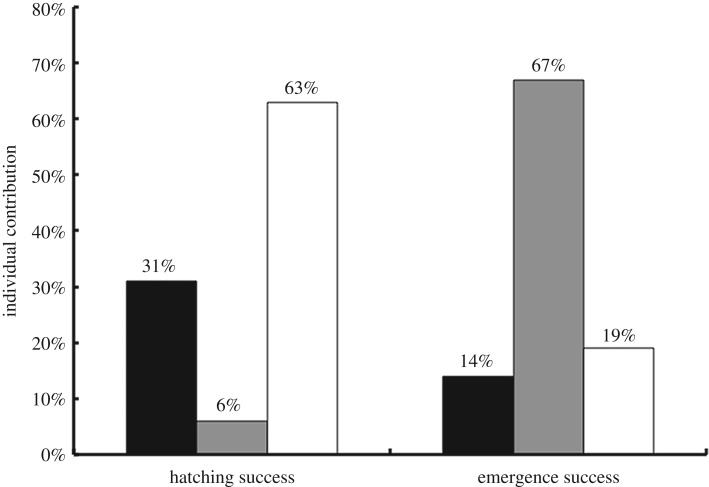
Results of hierarchical partitioning analysis investigating the influence of precipitation and temperature during incubation on clutch hatching success and emergence rate. Black columns represent precipitation before laying (one month), grey columns represent precipitation during incubation and white columns represent temperature during incubation. Values shown are unitless effect sizes and there is no standard accepted method for generating standard errors for these values. Thus no error bars are shown.